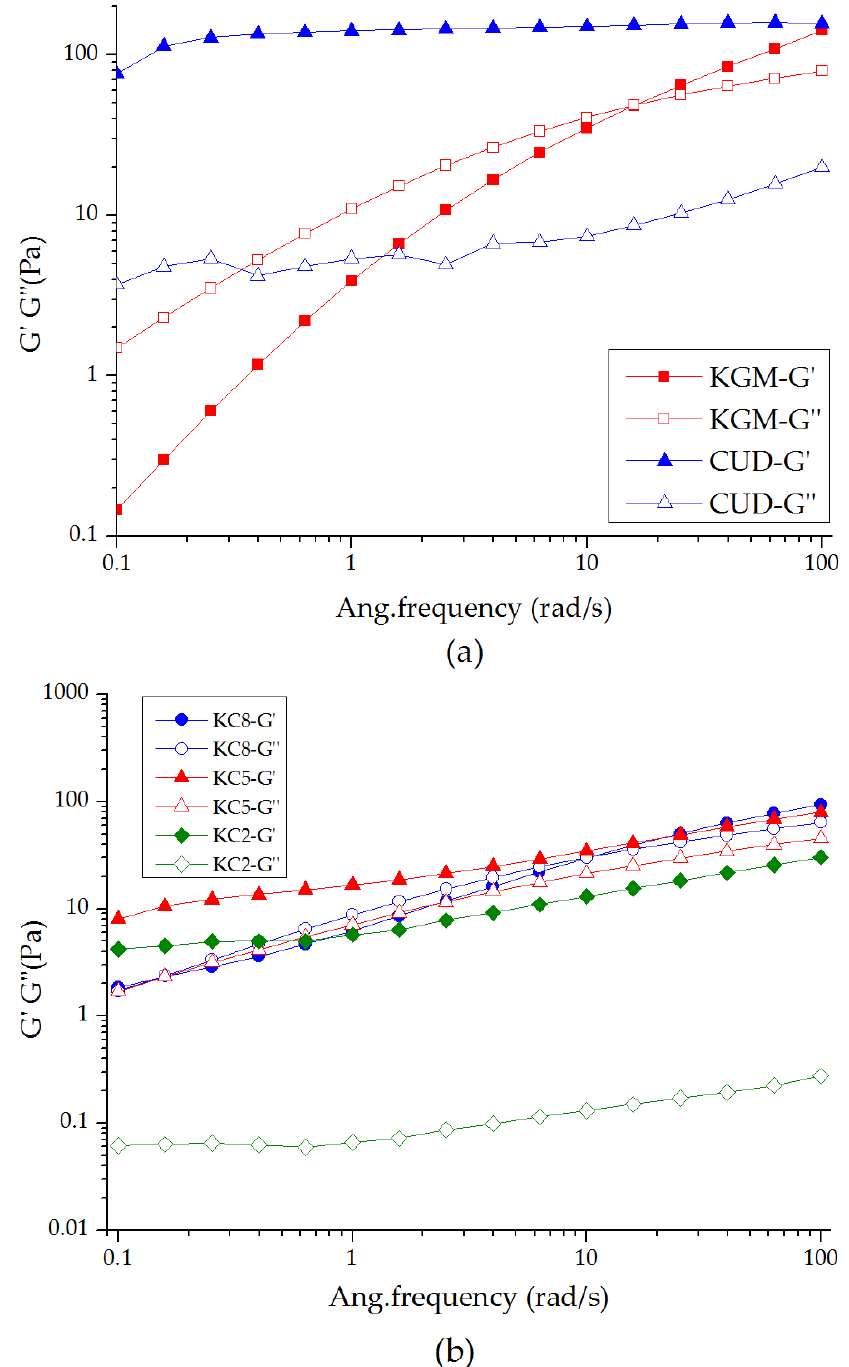
Figure 2. Curves showing the variations in G’ and G” of ( a ) KGM and CUD and ( b ) KGM/CUD blend systems with different mixture ratio at 25 °C at different angular frequencies.